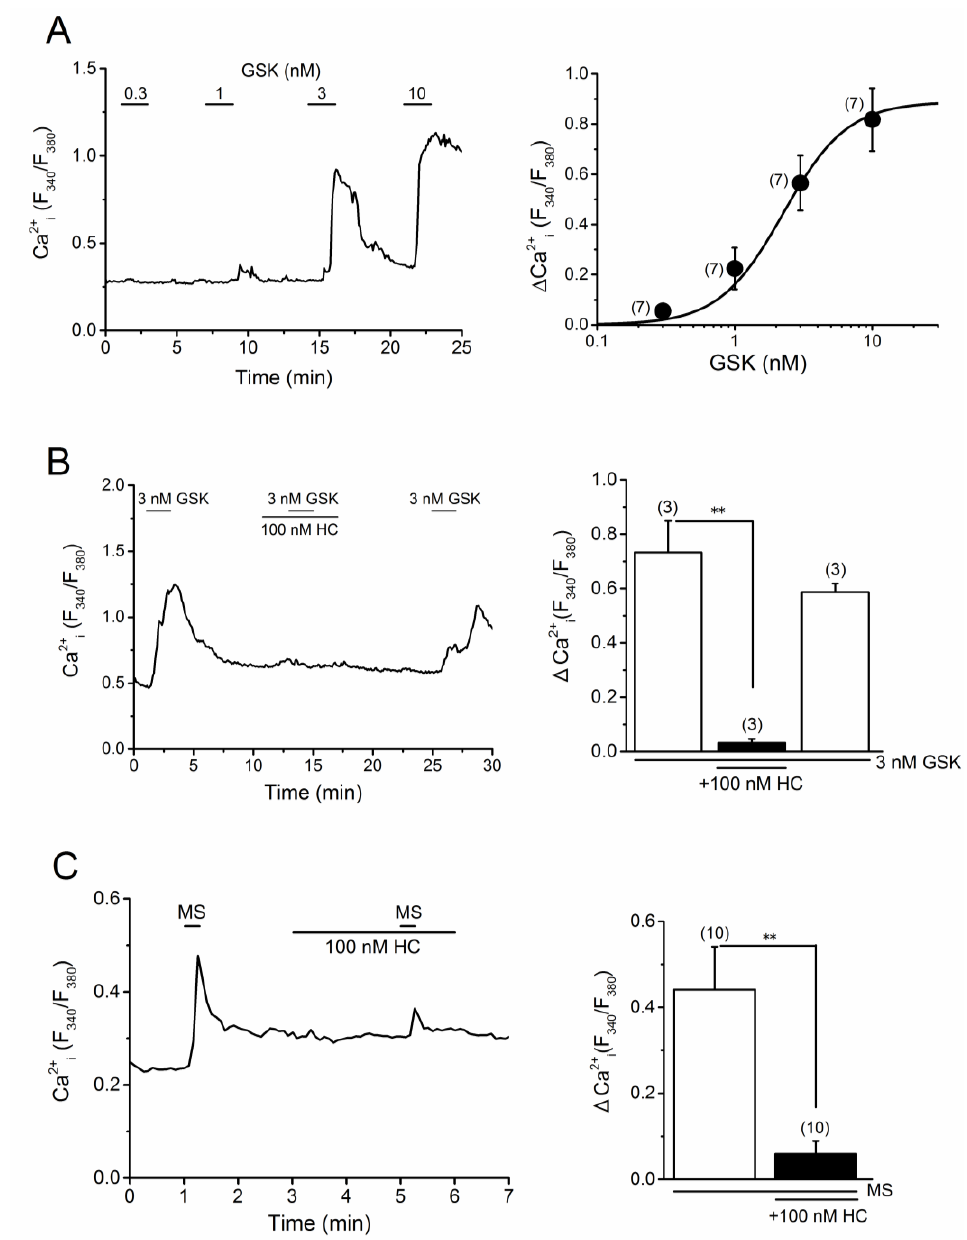
Figure 5. Potential involvement of TRPV4 in the MS-induced Ca 2 + response in MC3T3-E1 cells. ( A ) A representative Ca 2 + response of MC3T3-E1 cells to GSK, at concentrations ranging from 0.3 to 10 nM (left panel). The peak change in Ca 2 + response to GSK was summarized in the MC3T3-E1 cells and a set of data was fitted with a concentration-response relationship (EC 50 = 2.25 nM, n = 7, right panel). ( B ) A representative Ca 2 + response of MC3T3-E1 cells to GSK (3 nM) in the presence and absence of 100 nM HC (left panel) and summary of 3 nM GSK-induced Ca 2 + response before, during, and the washout of HC (right panel). ( C ) A representative Ca 2 + response of MC3T3-E1 cells to MS (7.67 μL/s) in the presence and absence of 100 nM HC was shown (left panel) and summarized (right panel). Pooled data were averaged and expressed as mean ± SEM. Statistical significance was established using Student’s t -test. ** p < 0.01, when compared to each corresponding control group. The numbers in parentheses indicate the number of independent experiments.